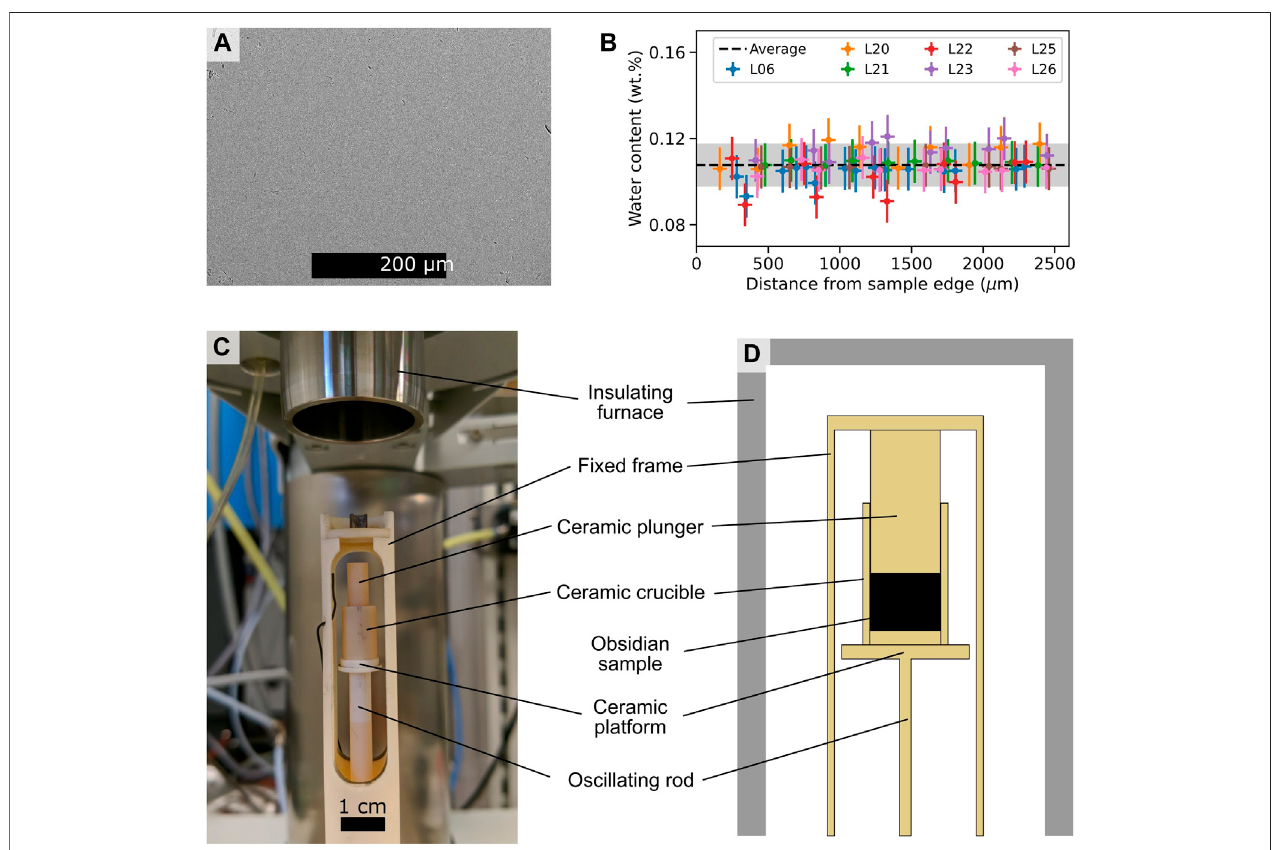
FIGURE 1 | (A) Backscattered electron image of the obsidian used in the experiments, showing the absence of microlites and vesicles. (B) Water contents of the original obsidian measured by FTIR spectroscopy, across slices cut from the end disks of seven samples; the average is shown as a black dashed line and the gray shaded region represents the analytical uncertainty. (C) Photograph and (D) schematic diagram of the experimental setup.